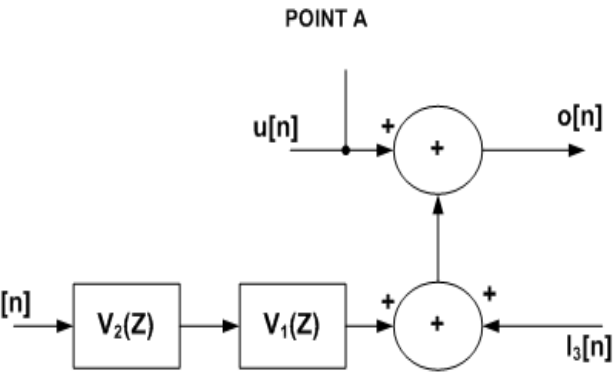
Figure 3. Dithering in proposed Architecture.